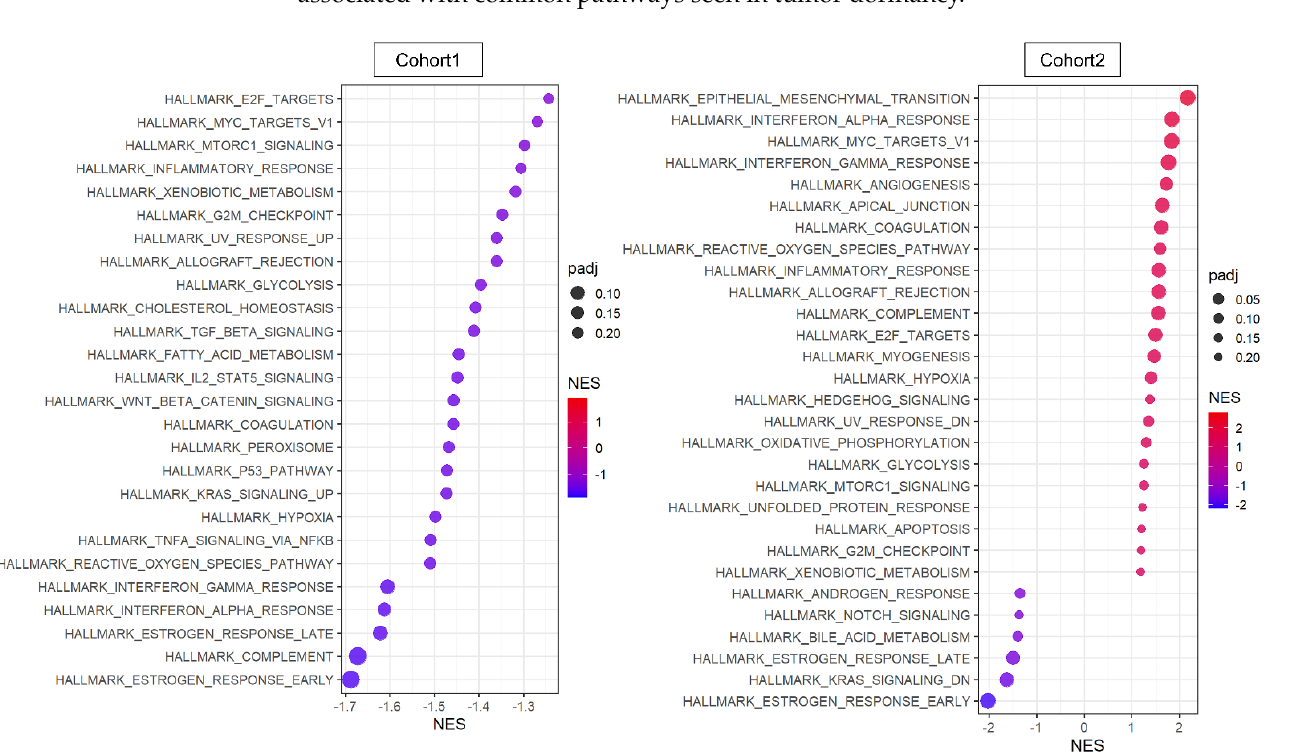
Figure 4. Pathway analysis of cancer cells that expressed any amount of NR2F1 . Dot plots showing GSEA comparing cancer cells with positive and negative NR2F1 expression in single − cell Cohort 1 ( left ) and Cohort 2 ( right ). Only significant gene sets from HALLMARK are shown in the figure. The size of each dot represents adjusted p value, and the x − axis and color tone represent NES.